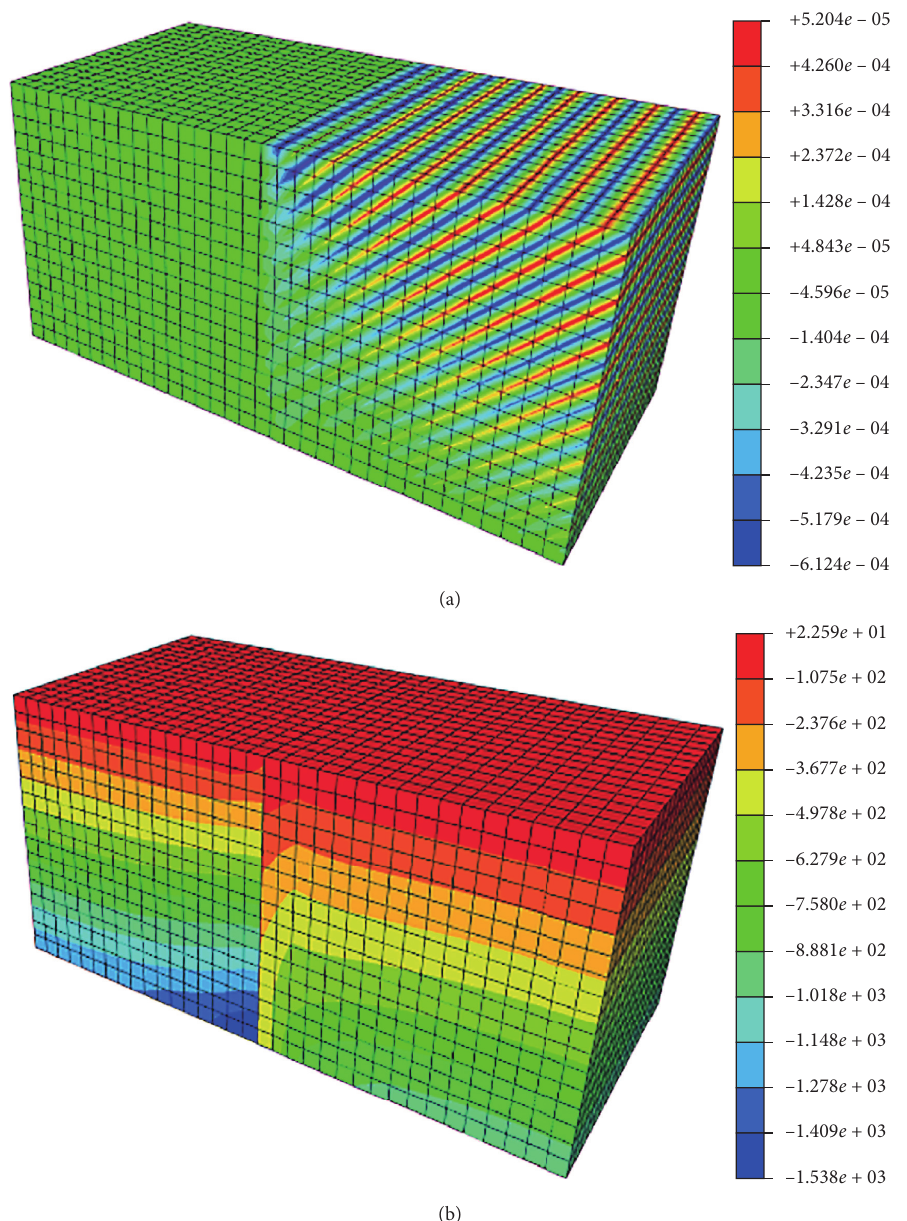
Figure 8: Simulation results of method D. (a) Vertical displacement results (unit: m) and (b) vertical stress results (unit: